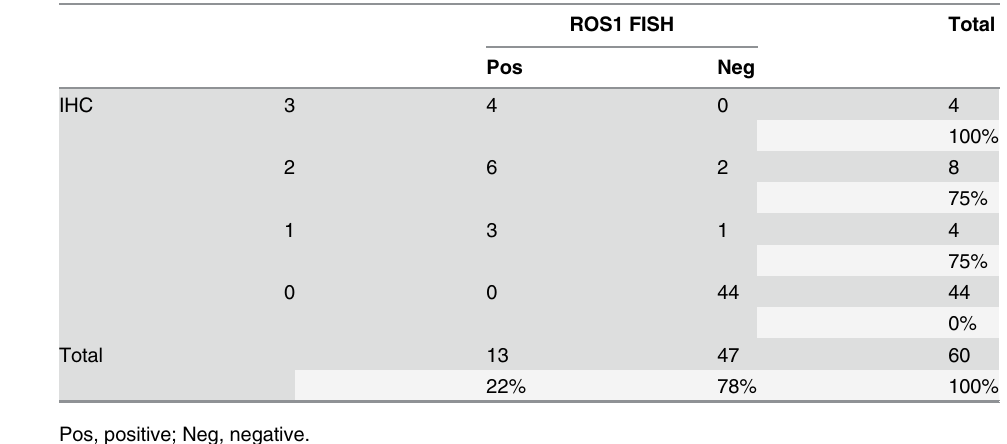
Table 2. Correlation of ROS1 IHC and FISH.